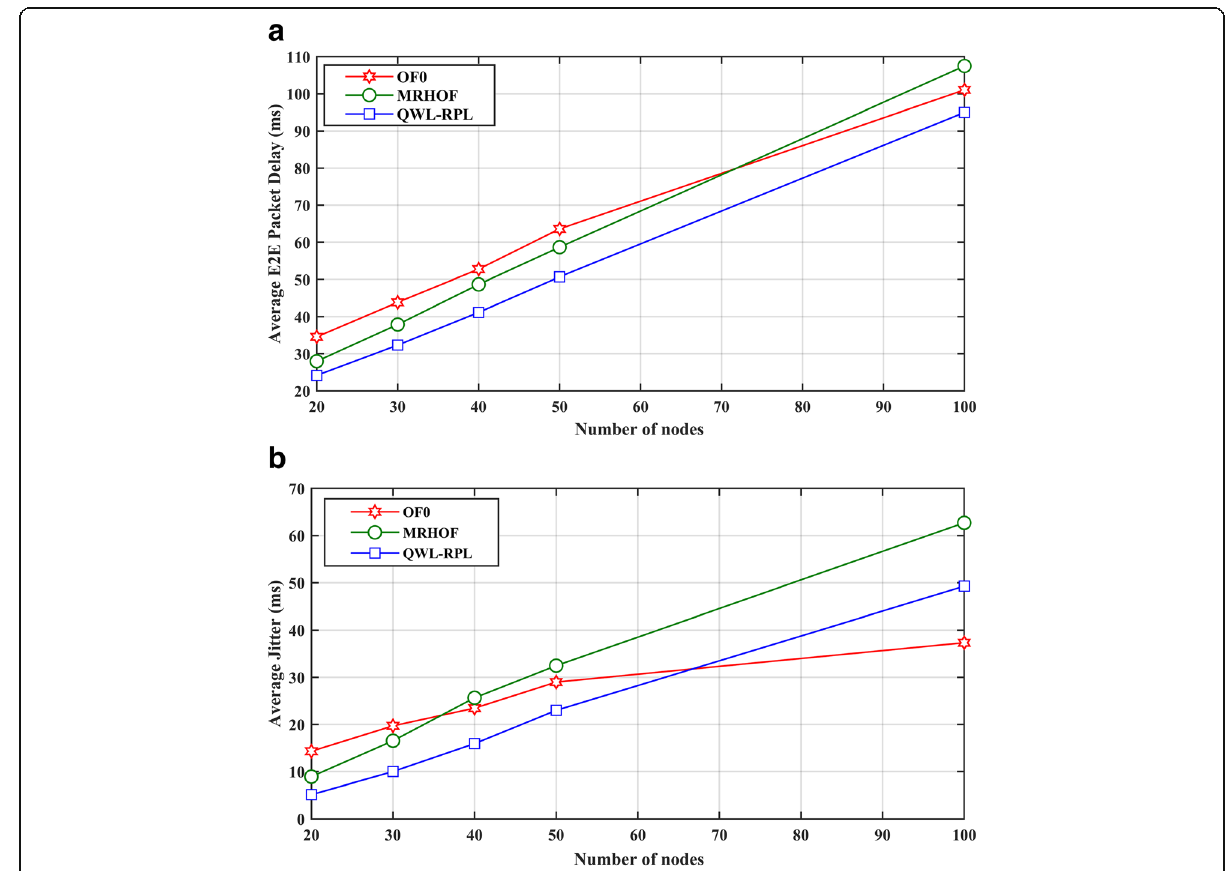
Fig. 9 Simulation analysis for scenario I for the a average E2E delay (ms) and b average jitter versus number of